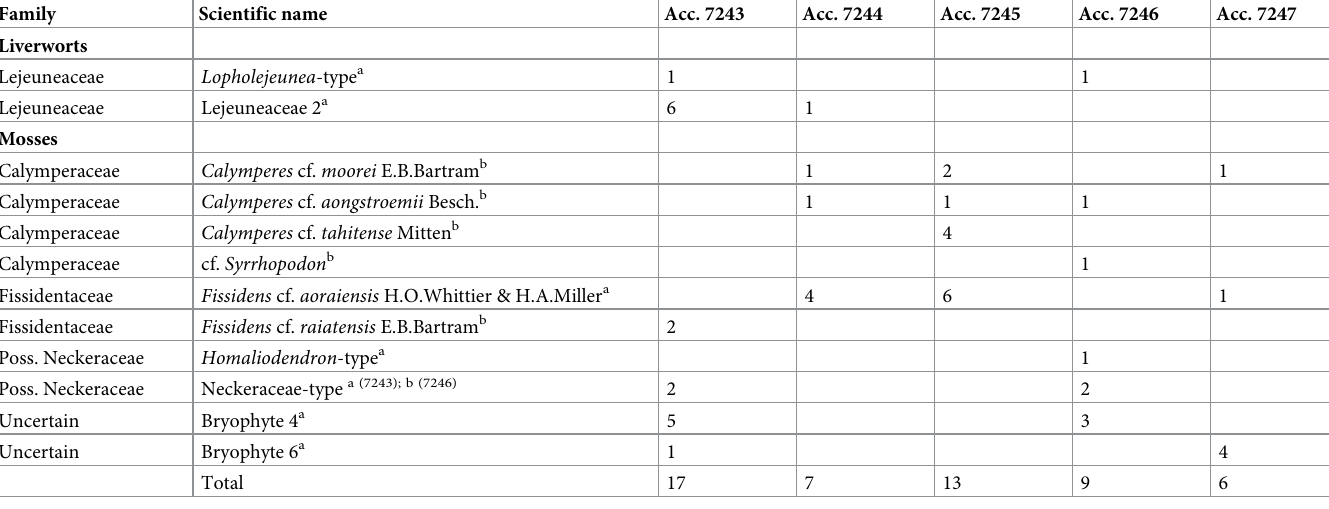
Table 4. Preliminary identifications and counts of subfossil bryophytes from five bulk sediment